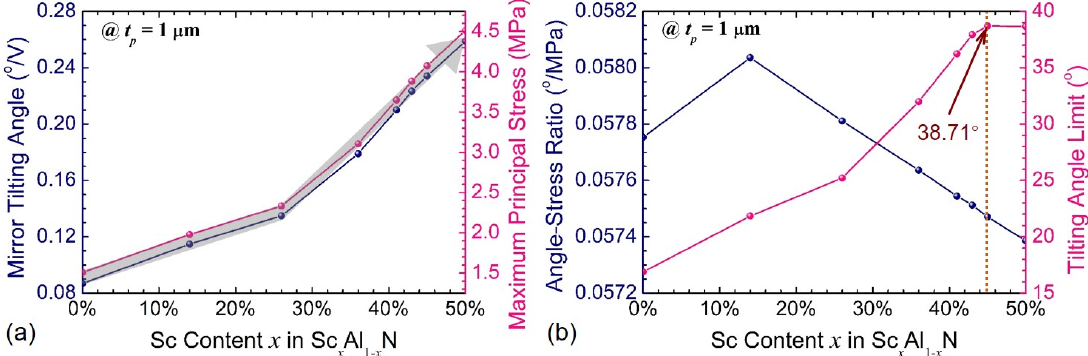
Figure 8. Dependence of the mechanical tilting angle and maximum principal stress on the Sc content: ( a ) mirror tilting angle, ( b ) angle-stress ratio.